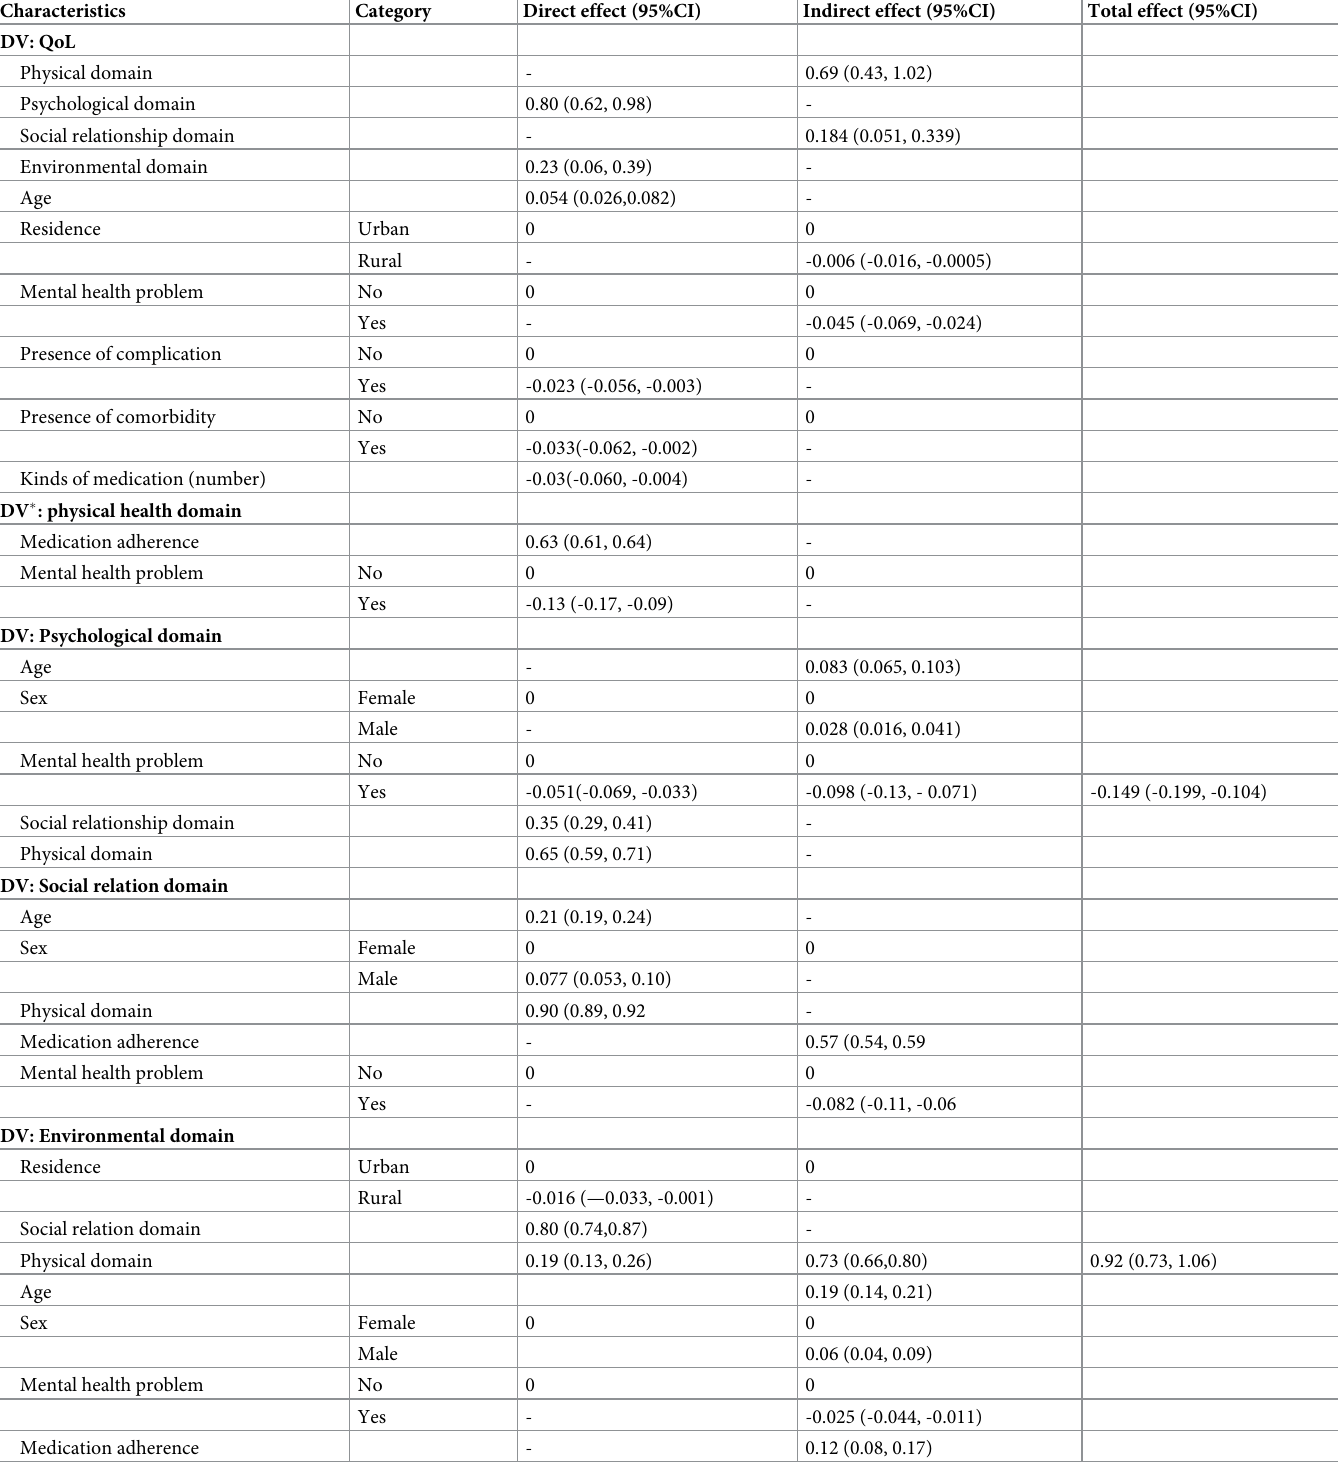
Table 4. The direct, indirect, and total effects of sociodemographic and clinical factors on quality of life among common chronic disease patients in Amhara region, Ethiopia, derived from the SEM, 2021.